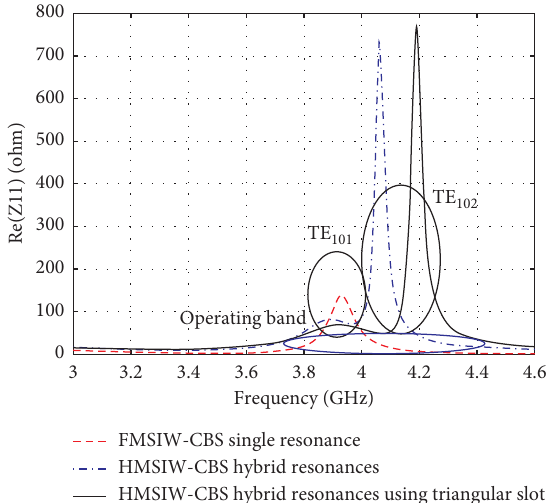
Figure 4: Real impedance ( Z 11 ) plot for antenna